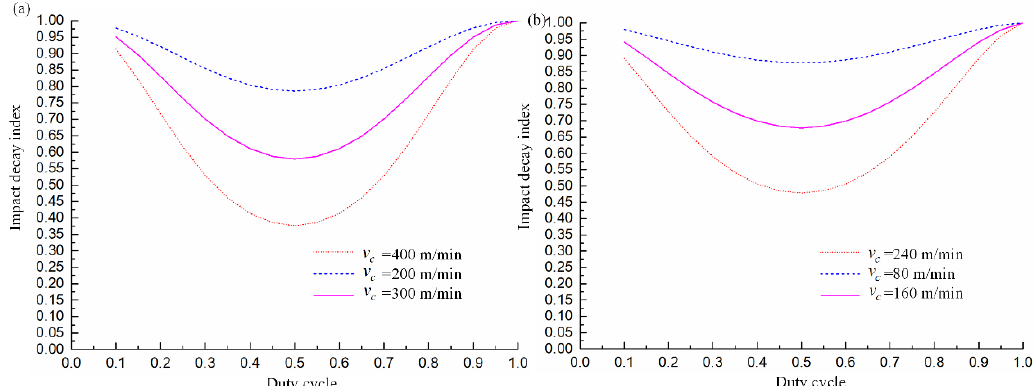
Figure 15. Tool life contribution components of the impact decay index in HUVC. ( a ) Ti alloys. Cooling pressure, feed per revolution, and cutting depth are 10 MPa, 0.005 mm/r, and 0.05 mm, respectively. ( b ) Ni alloys. Cooling pressure, feed per revolution, and cutting depth are 10 MPa, 0.005 mm/r, and 0.2 mm, respectively. 𝑣 𝑐 , cutting speed.